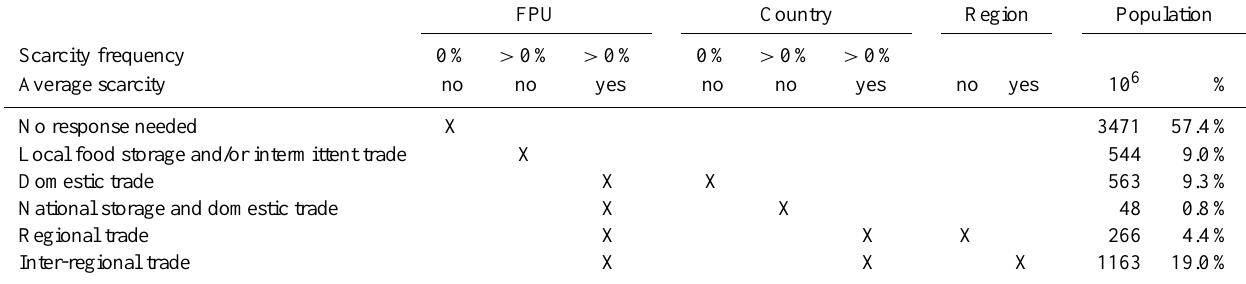
Table 2. Response options for FPUs, depending on the ability of to reach reference diet of 3000kcalcap − 1 yr − 1 (see map in Fig. 5 and FPUs in GBW matrix in Fig. 6). Scarcity frequency refers to the frequency of GBW scarcity (see Fig. 2b) and average scarcity on GBW scarcity under average climate conditions (see Fig. 2a) over our study period of 1977–2006.